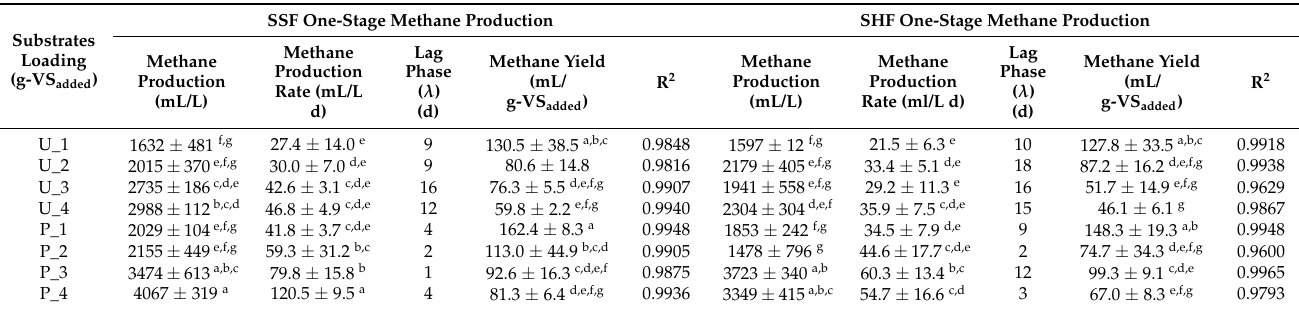
Table 7. Effects of substrate loading on enzymatic hydrolysis of untreated and DES pretreated sugarcane leaves by the cellulolytic consortium.